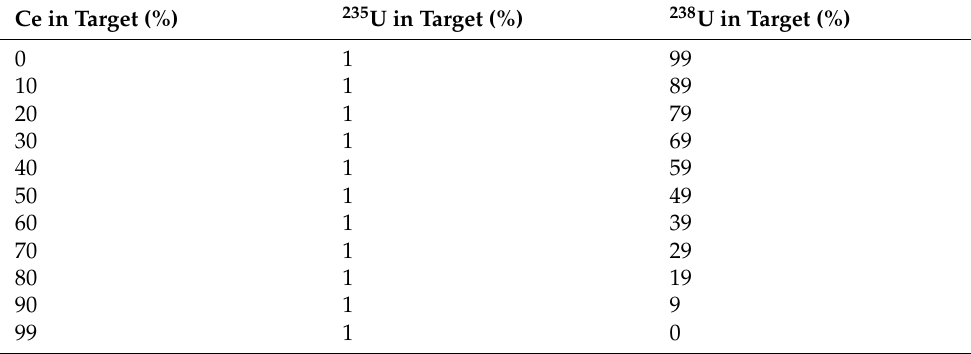
Table 1. Material compositions of